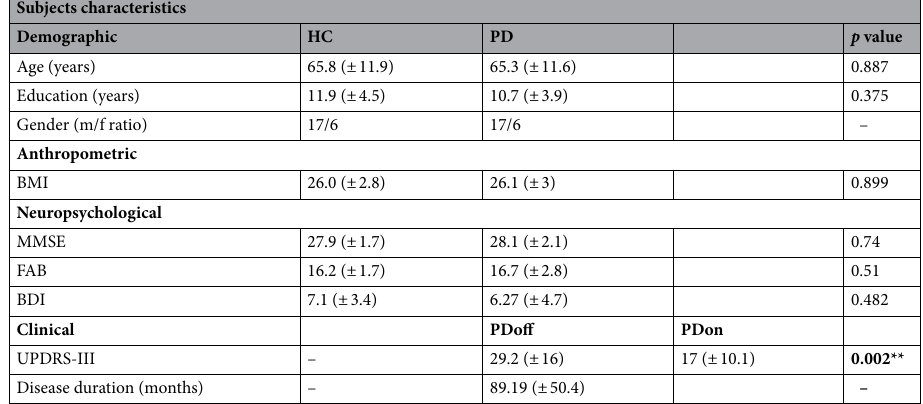
Table 1. Comparison between healthy control group (HC) and individuals with Parkinson’s disease (PD), for demographic, anthropometric, neuropsychological parameters. Clinical variables have been compared within the PD group before (PDoff) and after (PDon) L-DOPA intake. Body mass index (BMI), mini mental state examination (MMSE), frontal assessment battery (FAB), Beck’s depression inventory (BDI), unified Parkinson’s